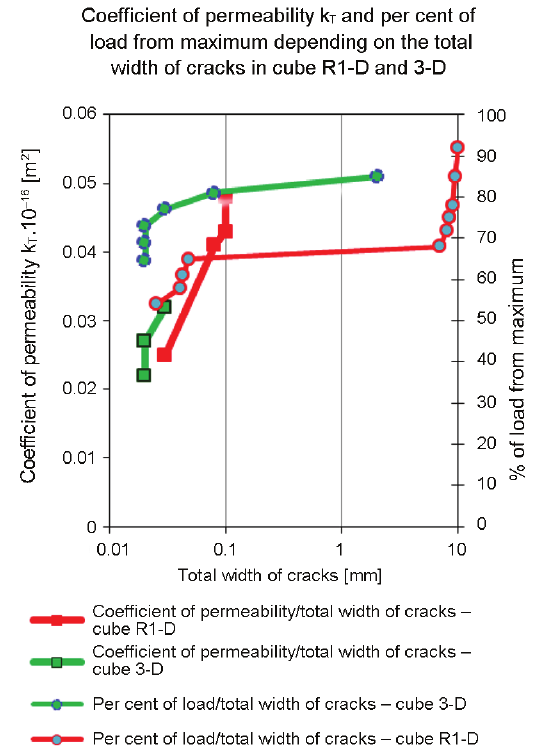
Fig. 11. Monitored dependencies on concrete cube R1-D and 3-D